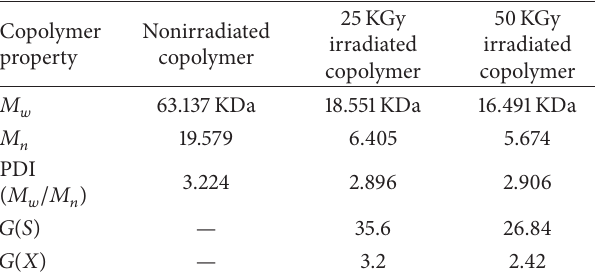
Table 2: Weight and number average molecular weights, polydis- persity index, scission yield 𝐺(𝑆) , and crosslinking yield 𝐺(𝑋) of irradiated and nonirradiated copolymer